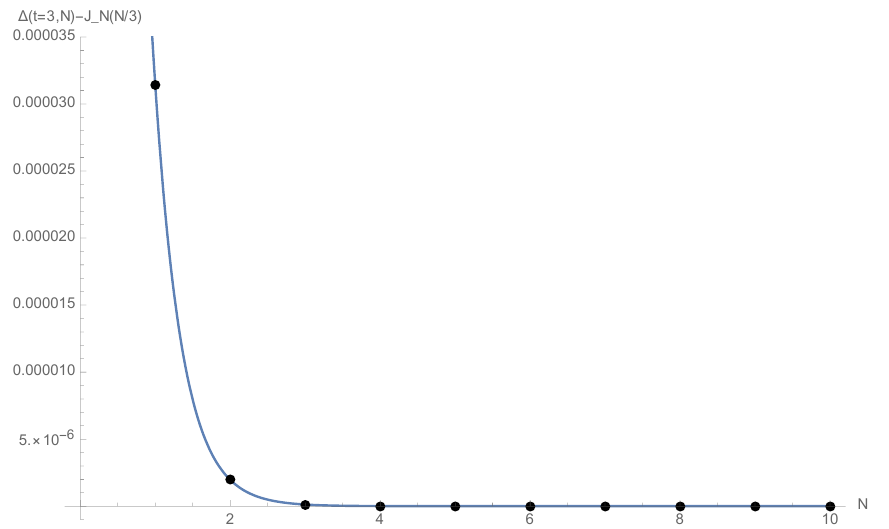
Figure 11 . The N dependence of the di(cid:11)erence between (cid:1)( t; N ) and the leading large N contri- bution J N ( N=t ) in the strong coupling regime, plotted here as the solid blue curve for t = 3 using (cid:0) (cid:1) the next trans-series term (cid:1) x = N ; N in (5.13). The black dots are the exact values for the (3) 3 di(cid:11)erence: (cid:1)( t; N ) (cid:0) J N ( N=t ), with t = 3. Even at N = 1 the di(cid:11)erence is tiny once we include this next non-perturbative